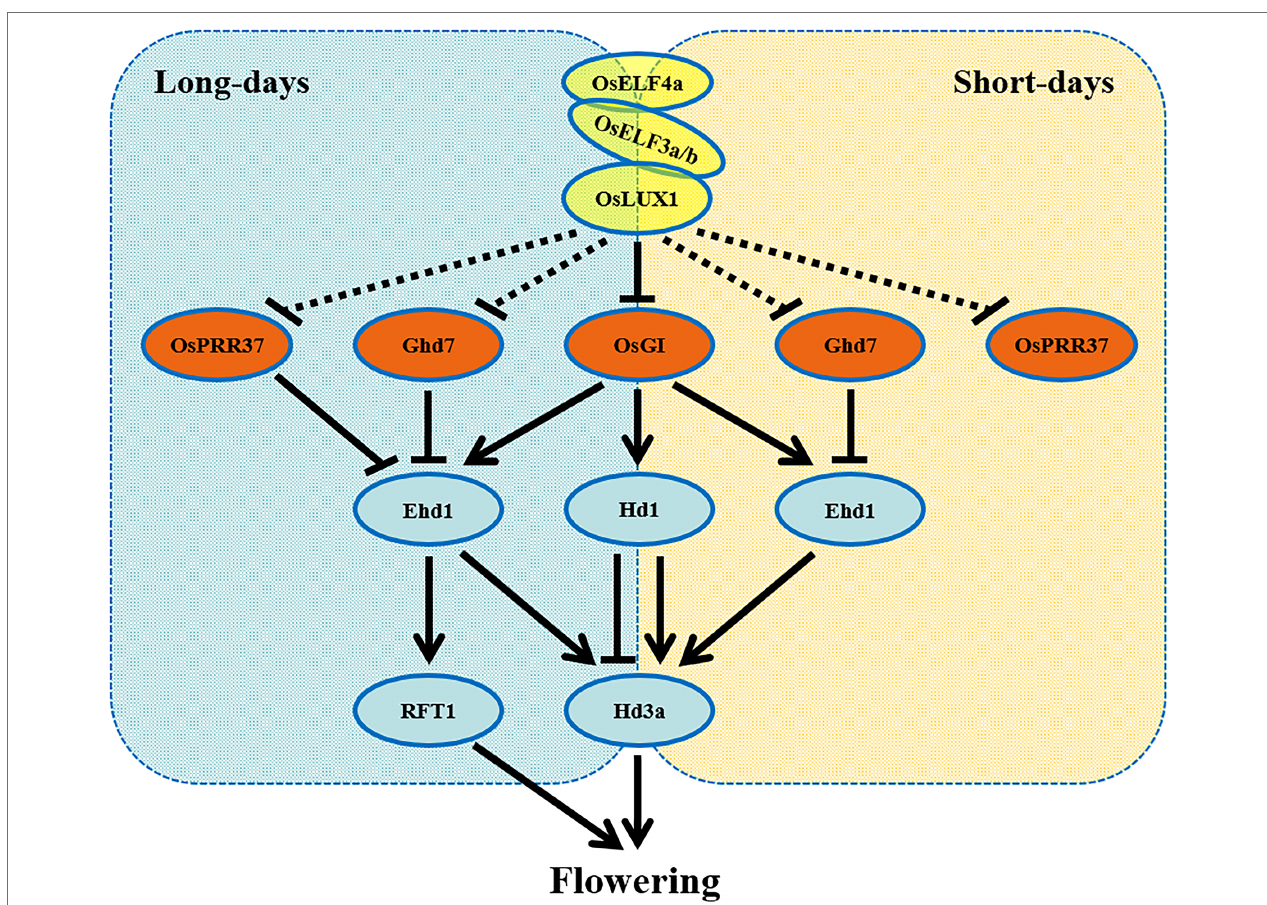
FIGURE 8 | A model for EC-mediated photoperiodic control of flowering in rice. The EC, composed of OsLUX, OsELF3a or OsELF3b, and OsELF4a, is an integrant of repressing flowering in rice. EC controls photoperiodic flowering via repressing the expression of PRR37 , OsGI , and Ghd7 under both LD and SD conditions, so as to regulate the expression of the critical output integrators Hd1 , Ehd1 , Hd3a , and RFT1 in